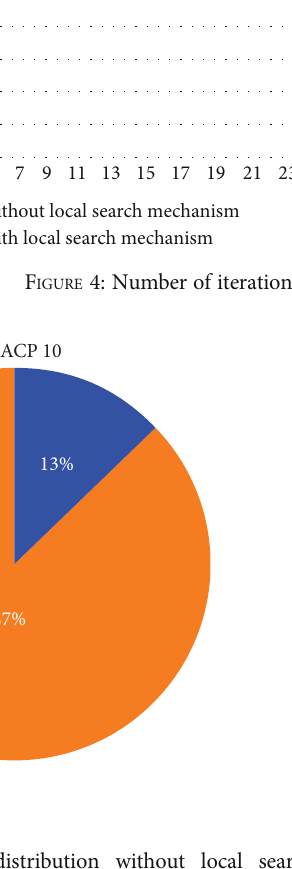
F IGURE 5: BACP 10 result distribution without local search mechanism.